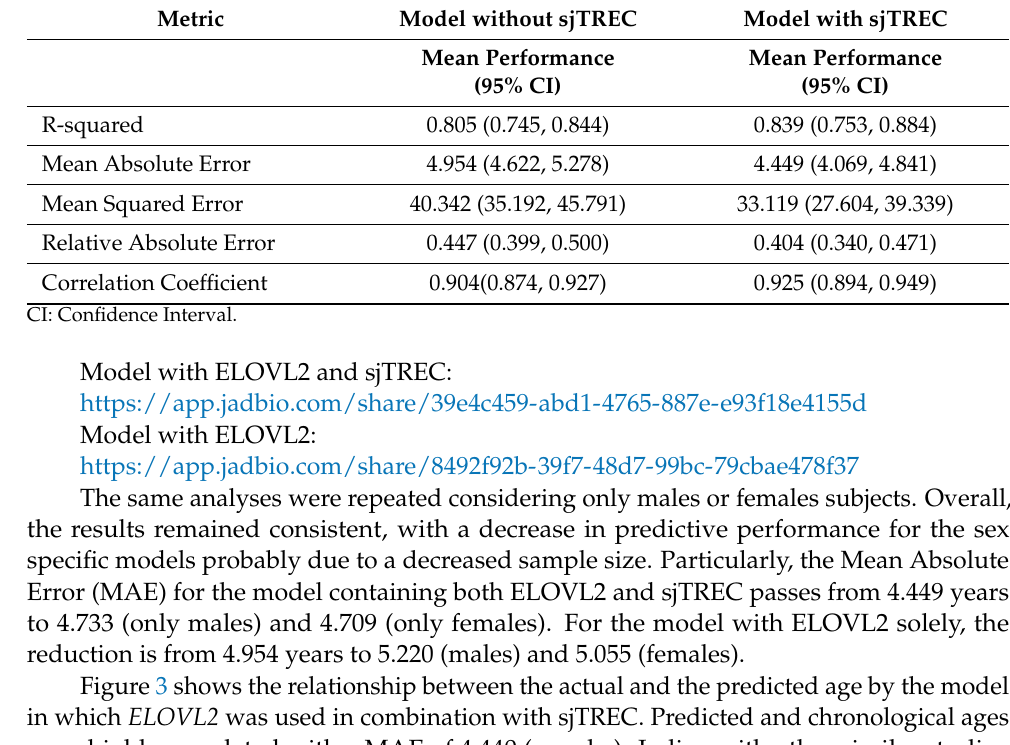
Table 3. Prediction accuracies of the SVR models obtained in JADBIO using the average methylation value of the ELOVL2 promoter region alone or in combination with sjTREC content.